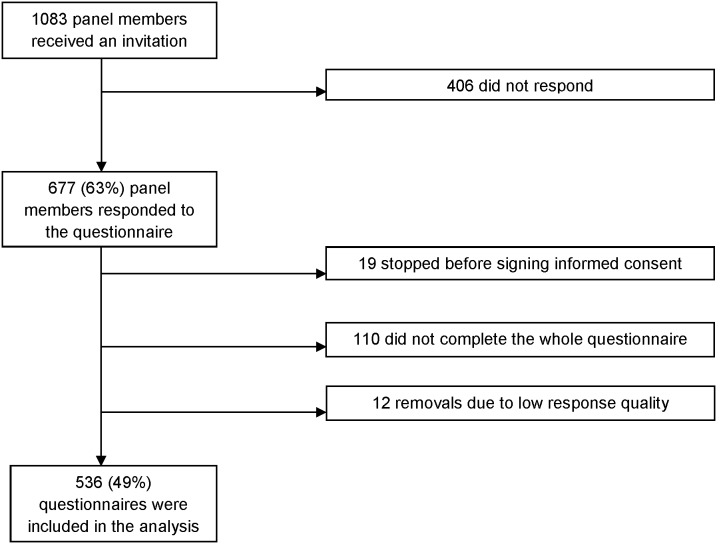
Overview of respondents accessing the study.